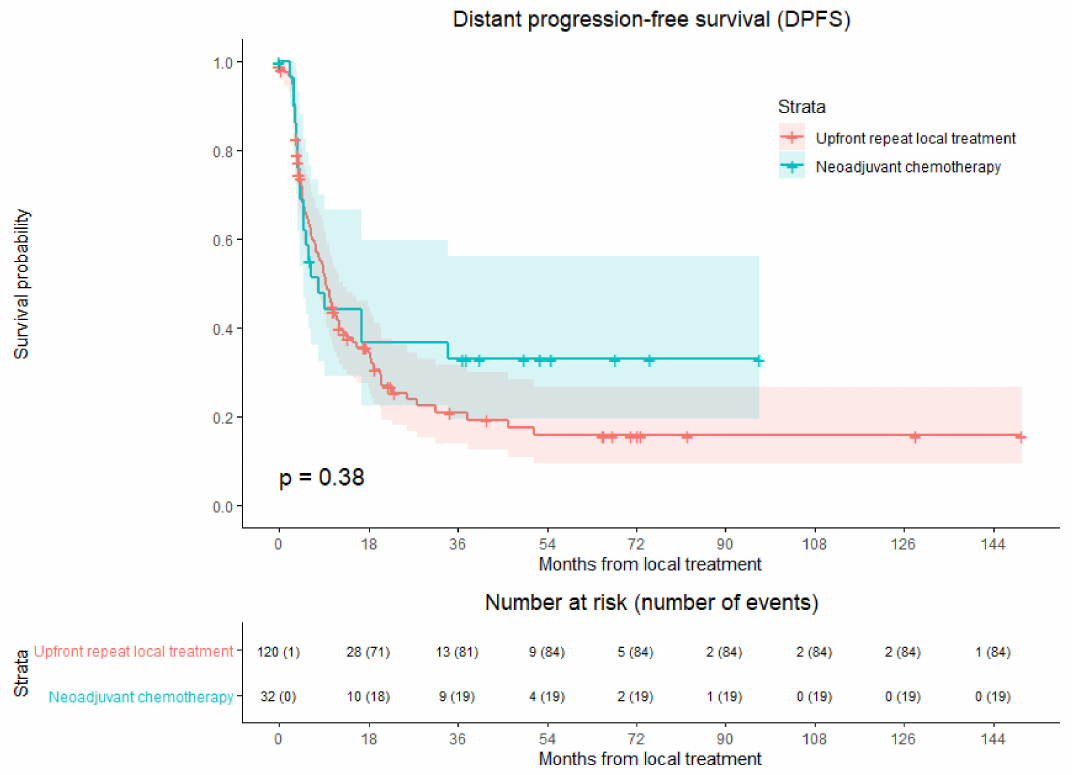
Figure 3. Kaplan–Meier curves of distant progression-free survival (DPFS) per patient after upfront repeat local treatment (red) and neoadjuvant chemotherapy followed by repeat local treatment (green). Numbers at risk (number of events) are per patient. Overall comparison log-rank (Mantel–Cox) test, p = 0.377. Death without distant progression (competing risk) is